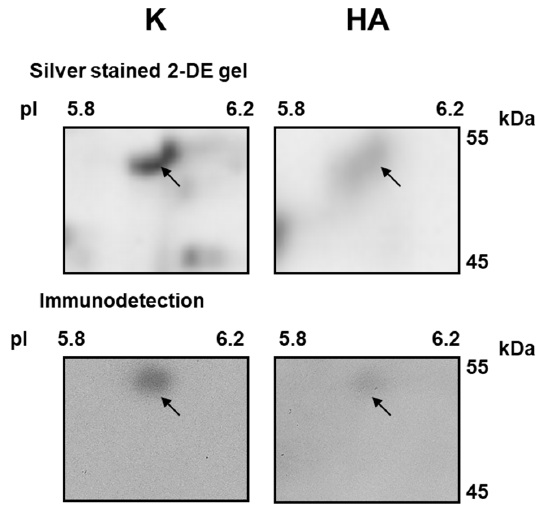
Figure 2. Immunoblotting of ATP1 on 2D blots containing cauliflower curd mitochondrial proteins from control grown plants ( K ) and from heat-recovered plants ( HA ). 100 µg of mitochondrial proteins were loaded onto all gels. 24-cm immobilized pH gradient strips (linear pH 3–10) for the first dimension and precast Ettan DALT 12.5% SDS-polyacrylamide gels for the second dimension were used. For protein transfer onto Immobilone membrane, a semidry system was applied. Blots were probed with polyclonal antibodies raised against mitochondrial ATP synthase subunit α (ATP1). Detection was carried with chemiluminescence assays after incubation with HRP-conjugated secondary antibody. Representative results (from triplicates) are shown. For the comparison, panels showing fragments of silver-stained 2D gels that contains spots for ATP1 are displayed. Arrows (indicated in each blot) show the position of ATP1 on immunoblots and 2D gels. Protein molecular mass standard (Thermo Fisher Scientific) sizes are given in kilodaltons (kDa); pI-isoelectric point. Further experimental details in the text.